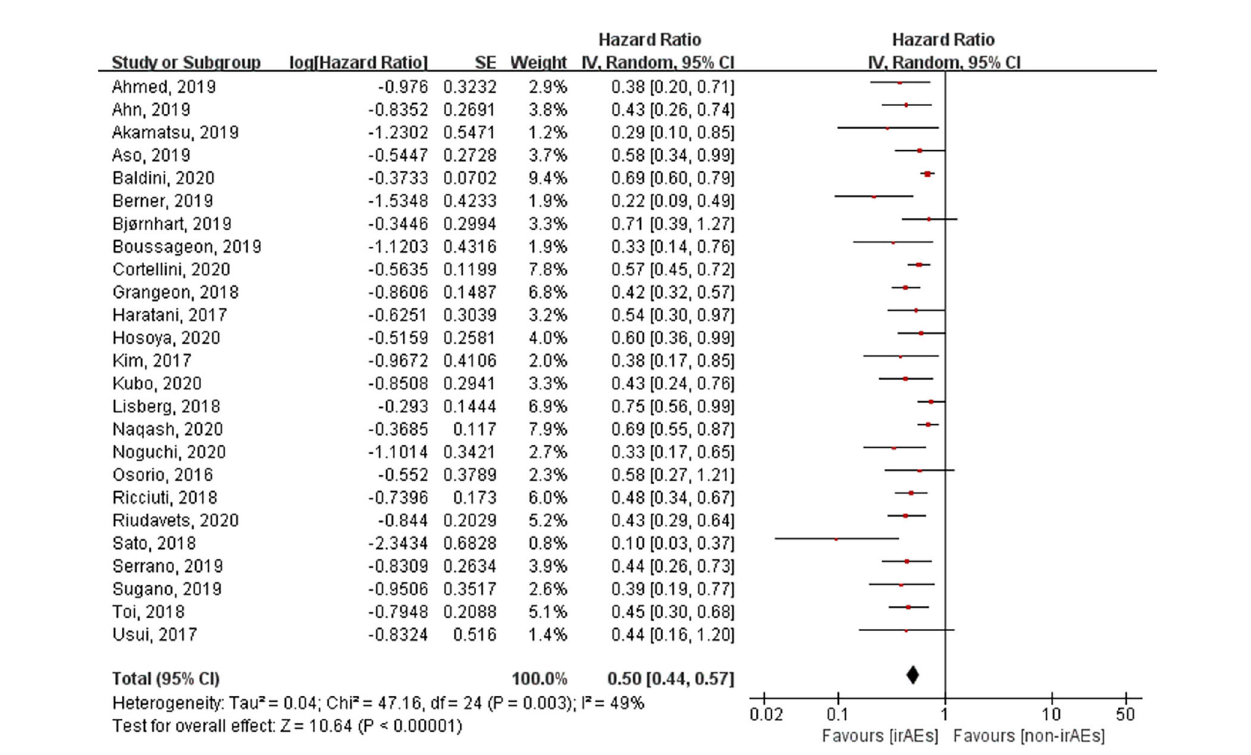
FIGURE 4 | Forest plot of the association between the occurrence of irAEs and PFS. PFS, progression-free survival; irAEs, immune-related adverse events; non- irAEs, non-immune-related adverse